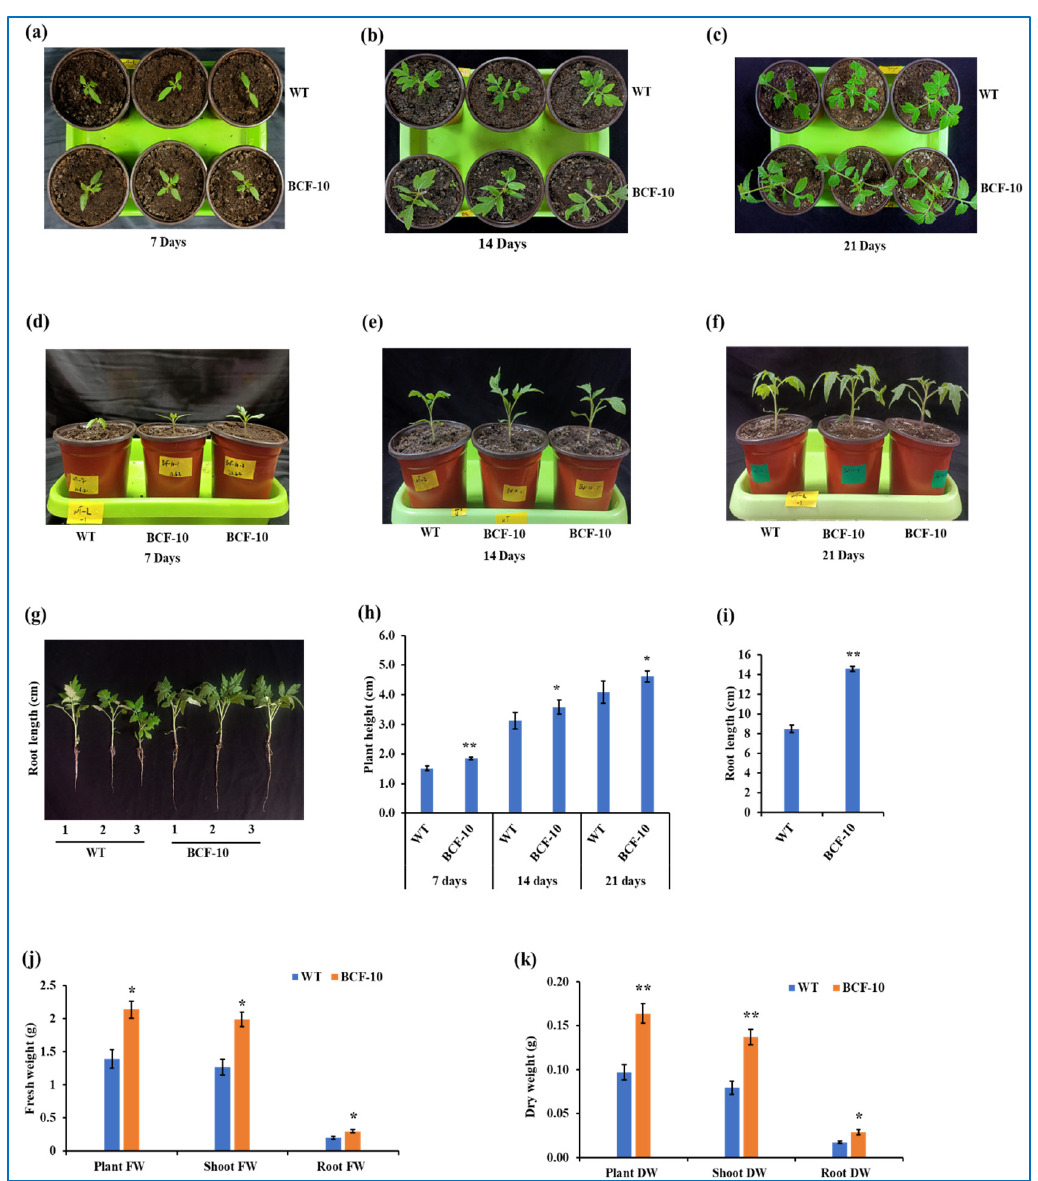
Figure 3. Morphological characterization of WT and BCF-OE plants under LL conditions. ( a – c ), Images showing the WT and BCF-OE plants that were grown under LL conditions for seven, fourteen, and twenty-one days. ( d – f ) Plant height of WT and BCF-OE plants at different LL treatment stages. ( g ) WT and BCF-OE plants’ root length after twenty-one days at LL treatment. ( h ) Plant height. ( i ) Root length. ( j ) Shoot, root, and total plants fresh weight of WT and BCF-OE plants. ( k ) Shoot, root, and total plants’ dry weight after being grown under LL conditions for three weeks. The data point averages six replicates, and SE represents standard error. Asterisks indicate a significant difference compared to WT (Student’s t -test, * p < 0.05, ** p <